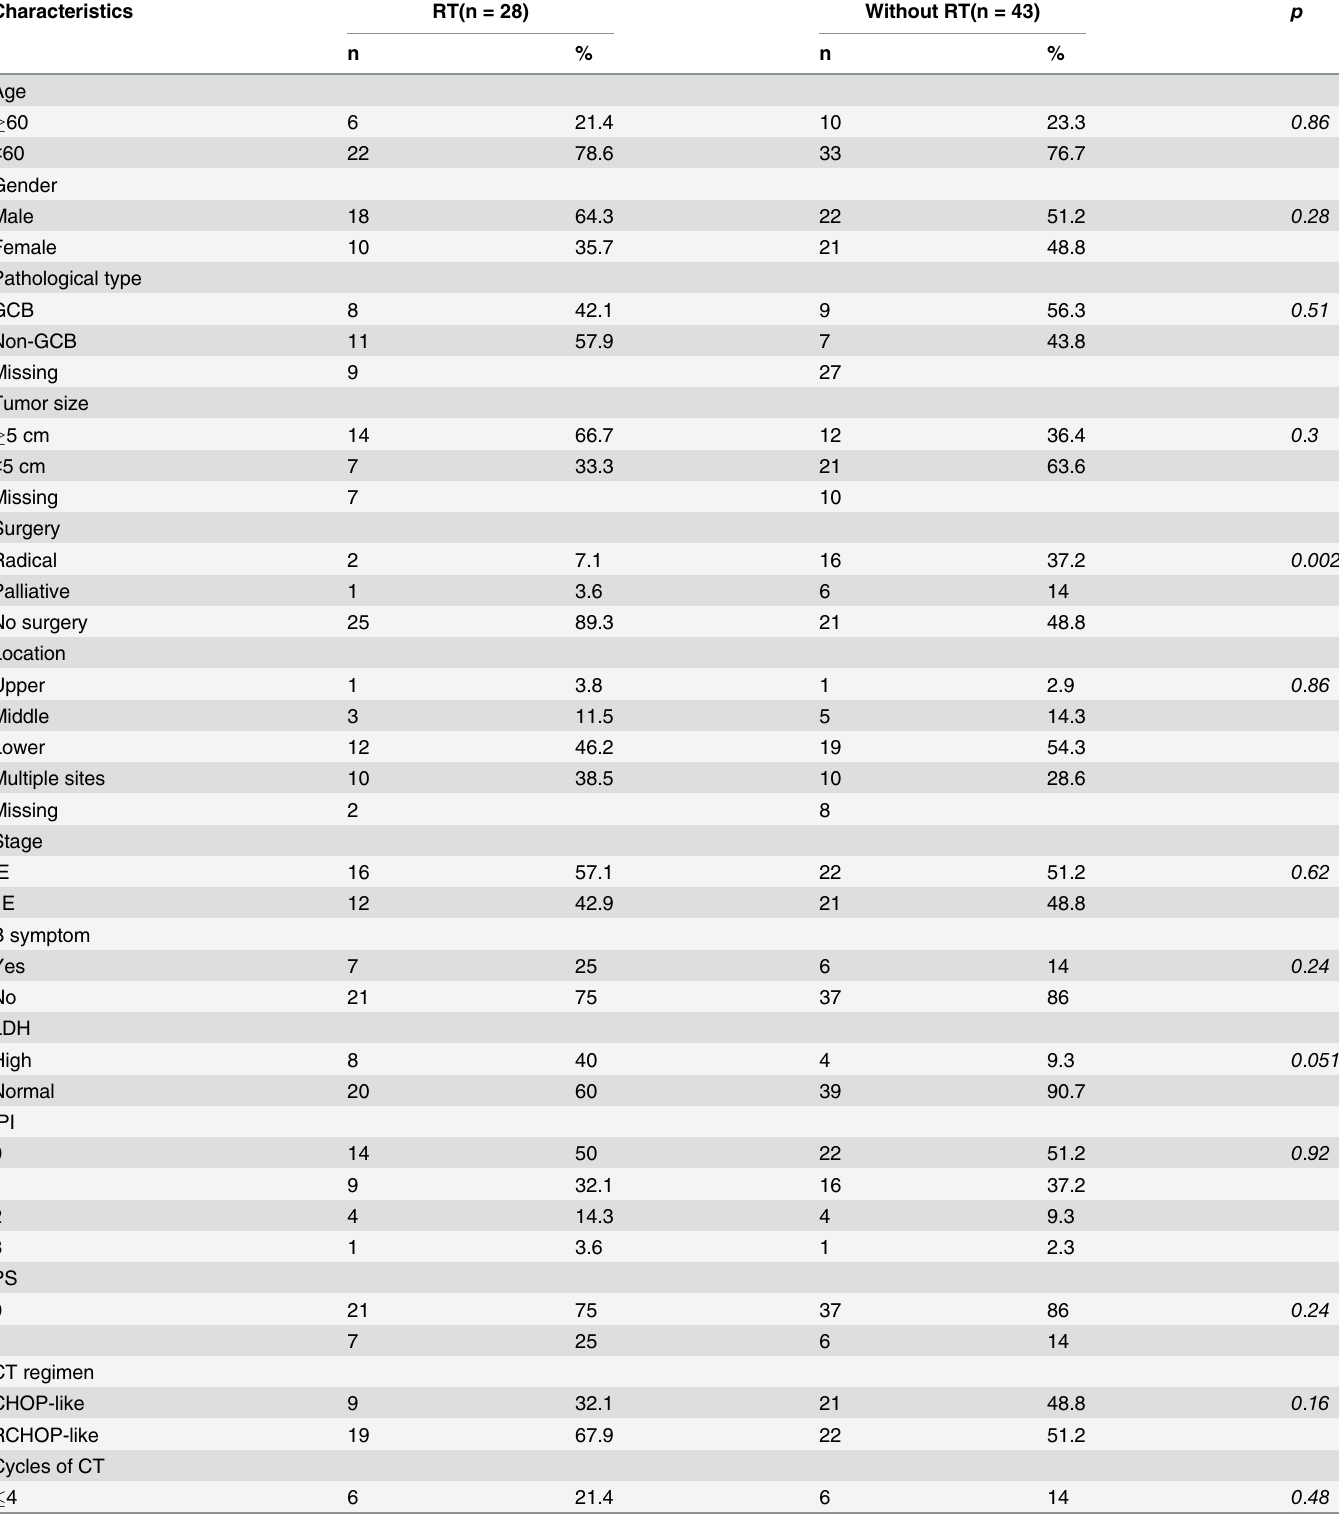
Table 1. Baseline clinico-pathologic